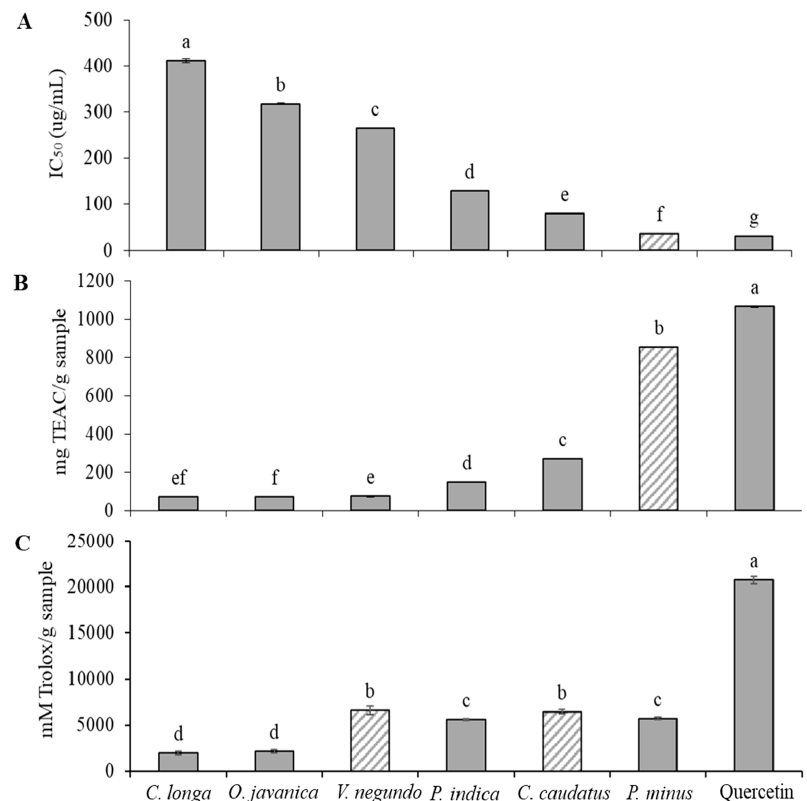
Figure 1. Radical scavenging activity of selected herbs leaves. A : 2,2-diphenyl-1-picrylhydrazyl (DPPH) assay, B : 2,2-azinobis(3-ethyl-benzothiazoline-6-sulfonic acid) (ABTS) assay, C : Oxygen radical absorbance capacity (ORAC) assay, IC 50 : extract concentration required for 50% inhibition. Means with the same letters are not significantly different ( p > 0.05).